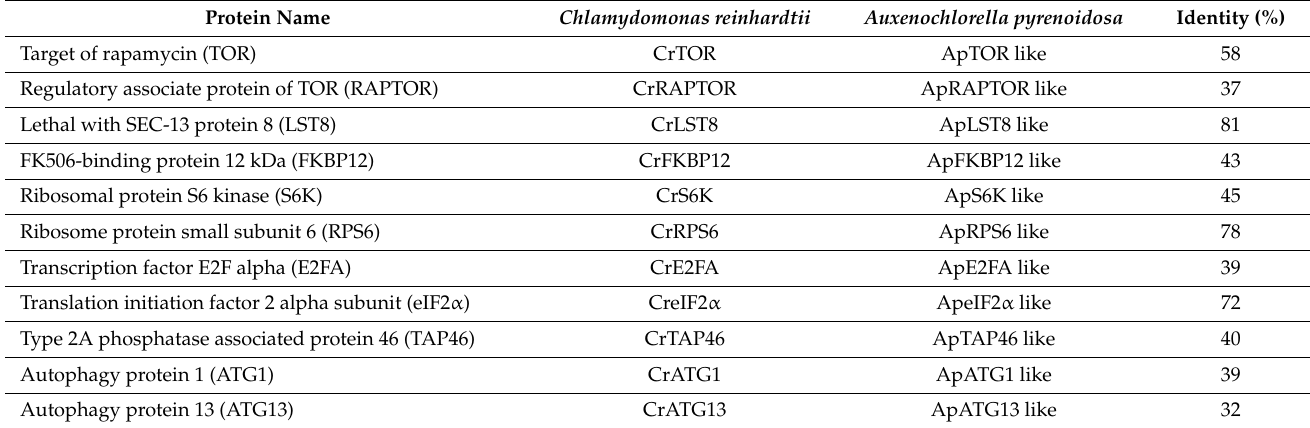
Table 1. The putative components of TOR signaling pathway in Auxenochlorella pyrenoidosa